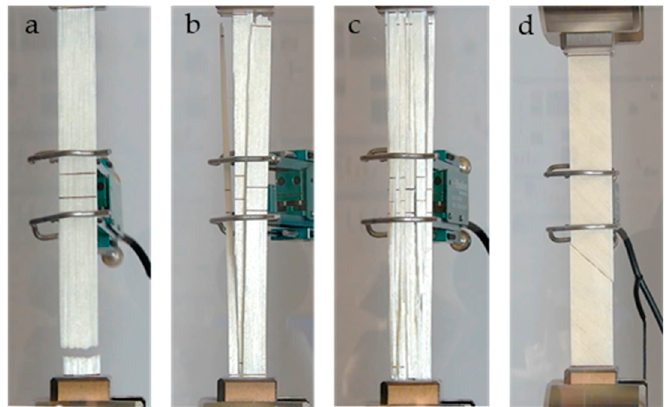
Figure 7. Tensile failure SFRC with axial load for V f = 20% ( a ), V f = 40% ( b ), V f = 60% ( c ) and with off-axis load ( d ).